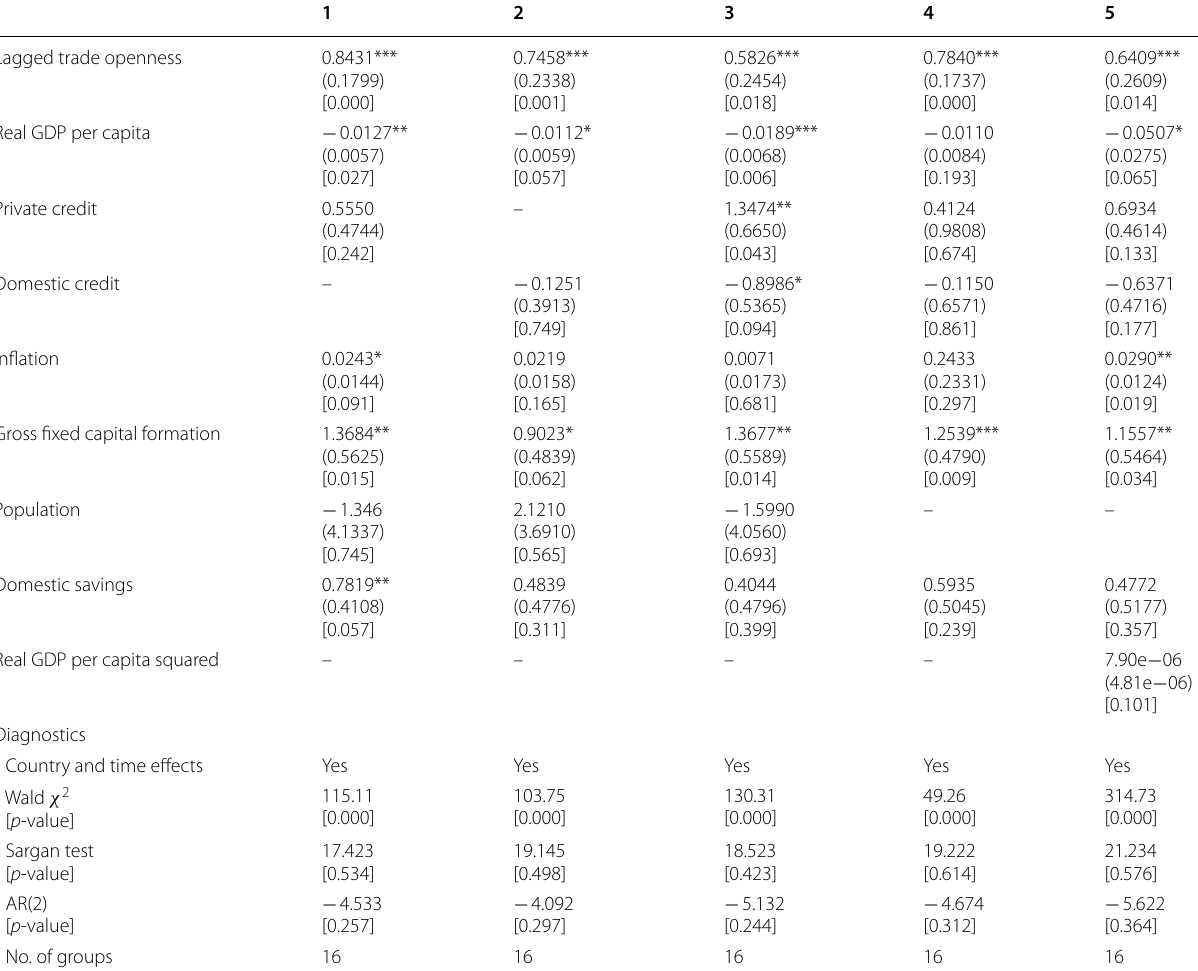
Table 3 Determinants of trade openness in